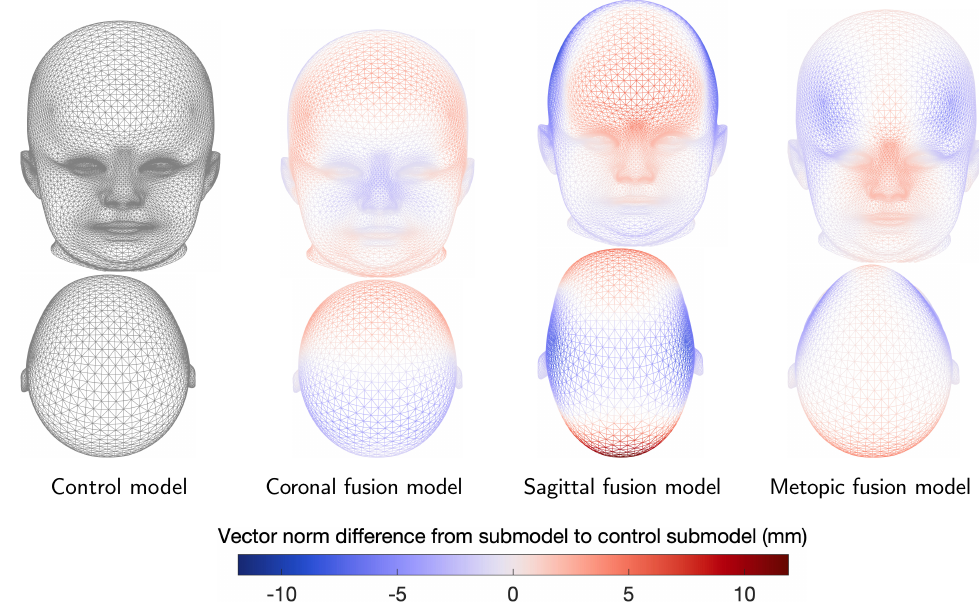
Figure 7. Mean shapes of pathology-specific submodels, front and top view. From left to right: control model, coronal suture fusion model, sagittal suture fusion model, and metopic suture fusion model. Color bar indicates vector norm difference between principal component shape and mean shape (gray).